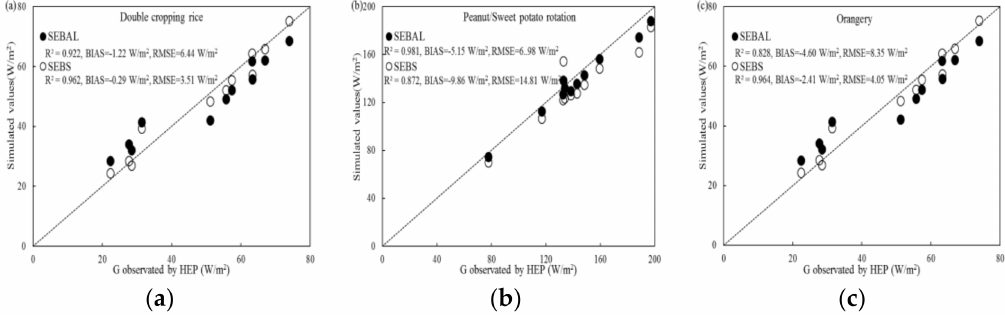
Figure 3. Comparison of simulated soil heat flux with the observed values by soil heat flux plates: ( a ) double cropping rice, ( b ) peanut/sweet potato rotation, ( c )